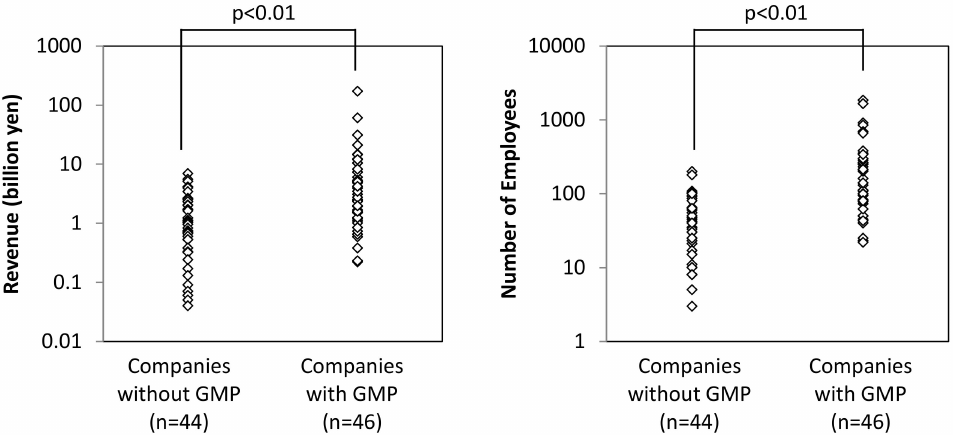
Figure 3. Revenue and number of employees of contracted manufacturing organizations (CMOs) for dietary supplements with and without GMP in Japan.